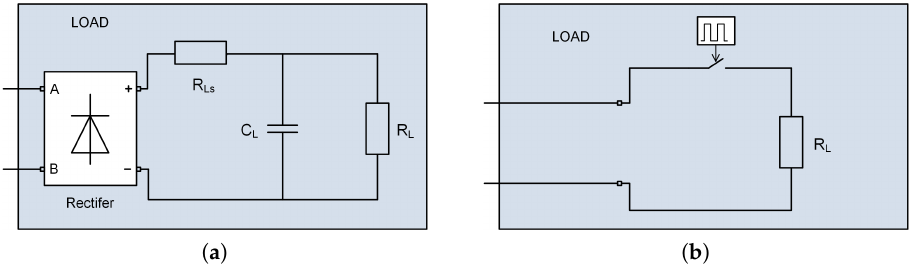
Figure 2. Models of the loads. ( a ) Non-linear rectifier RC load, R Ls = 1 Ω , R L = 100 Ω , C L = 430 µ F ( b ) Periodically switched resistive load, R L = 50 Ω